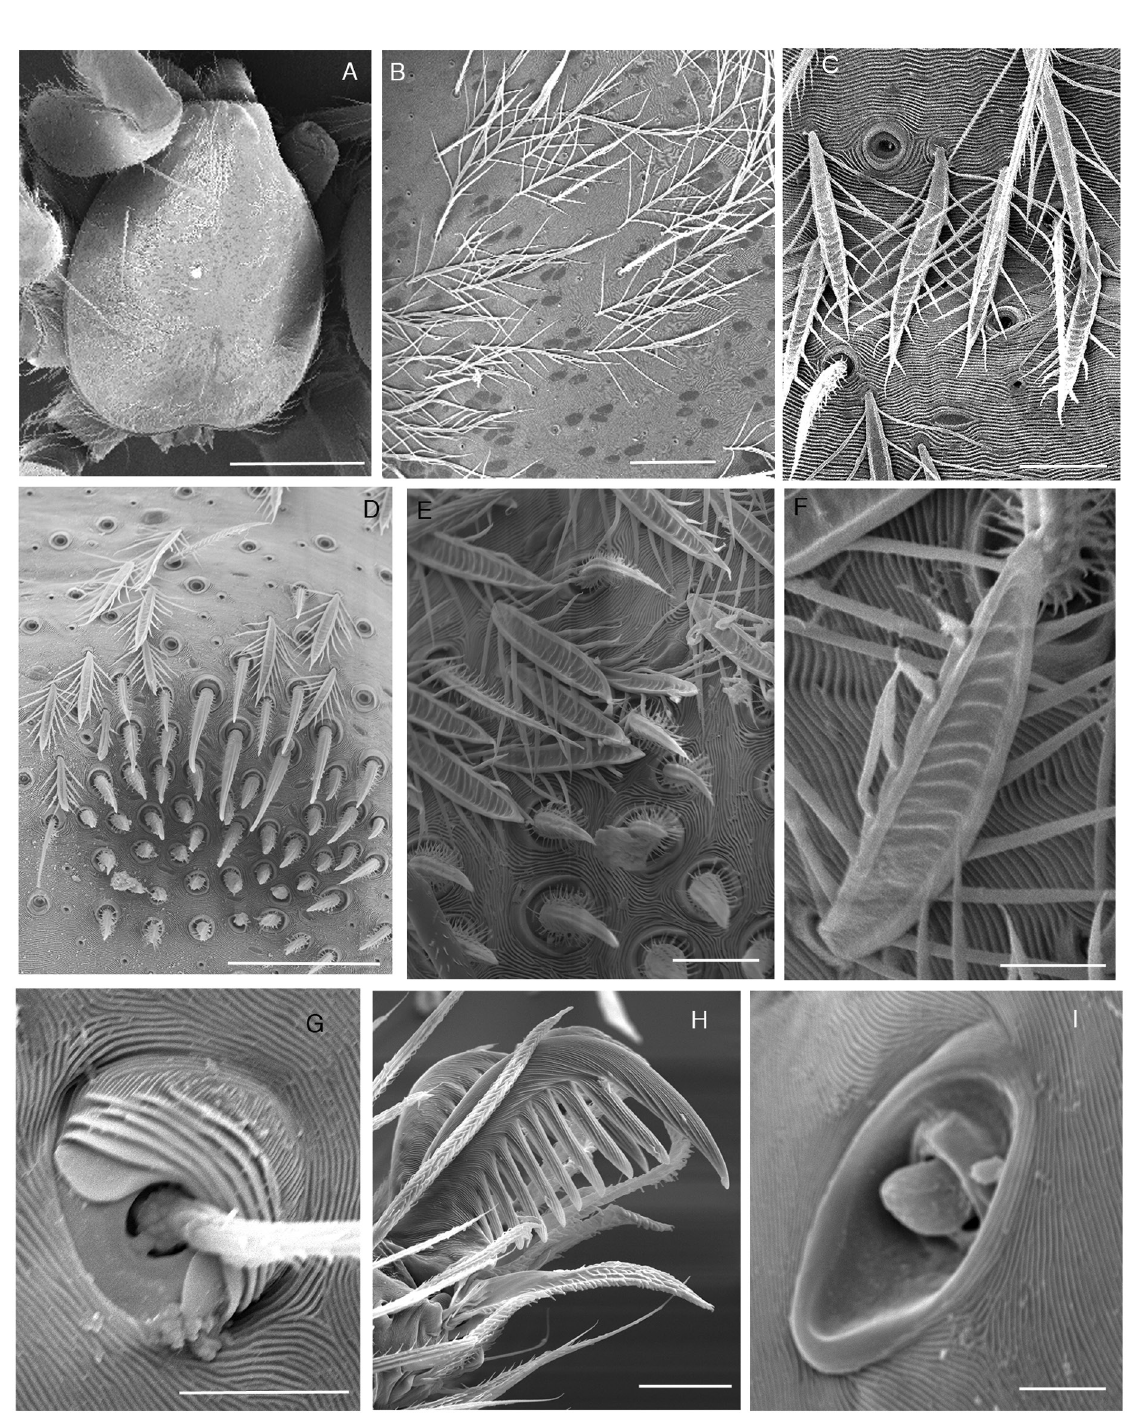
Fig. 6. Cteniogaster hexomma sp. nov. A. ♂, carapace, dorsal view. B. Detail of previous. C. ♀, setae on venter of abdomen. D. ♂, group of modified setae on venter of abdomen. E. Detail of previous. F. Detail of seta surrounding patch of modified setae. G. ♀, trichobothrium on tibia I. H. ♀, tarsal claws leg I. I. ♀, tarsal organ leg I. Scale bars: A = 0.5 mm; D = 50 μm; B, H = 20 μm; C, E = 10 μm; F, G, I = 5